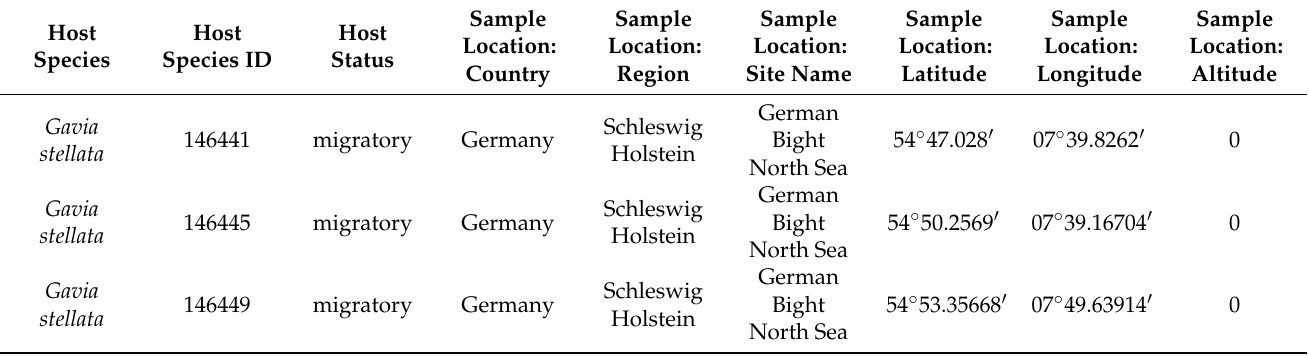
Table A2. Specific information on the sample locations of birds infected with new lineages.